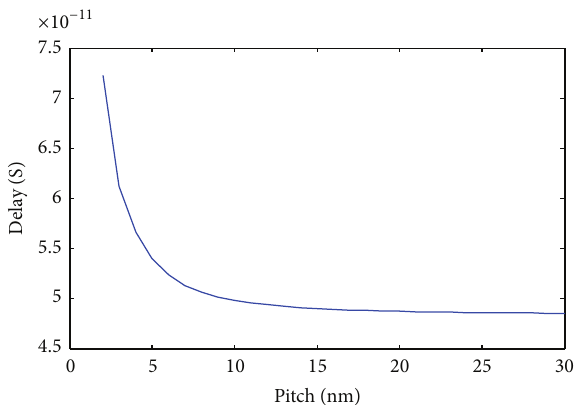
Figure 13: The effect of pitch on delay for pure-CNFET inverter.